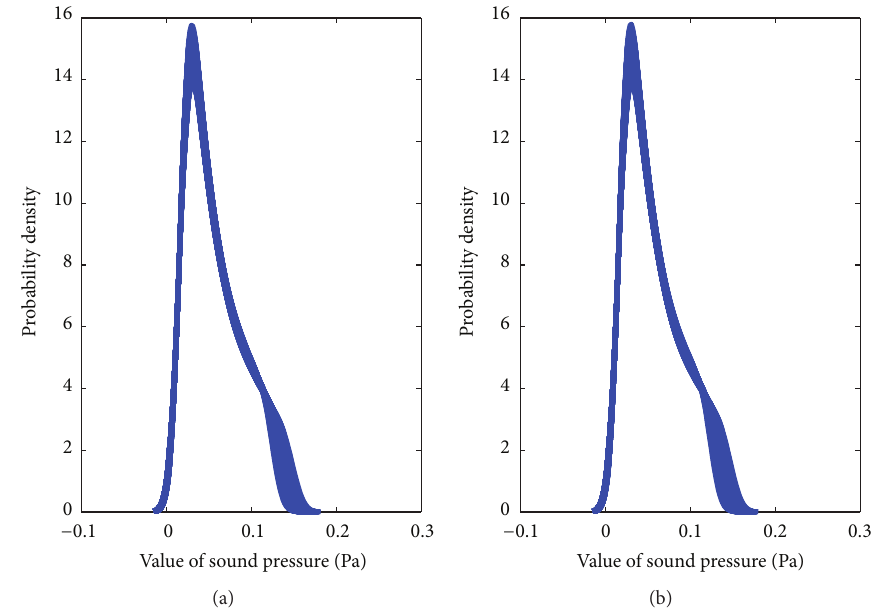
Figure 15: The lower and upper bounds of the response probability density of node 𝑅1 calculated by (a) MCS and (b) PCRS.